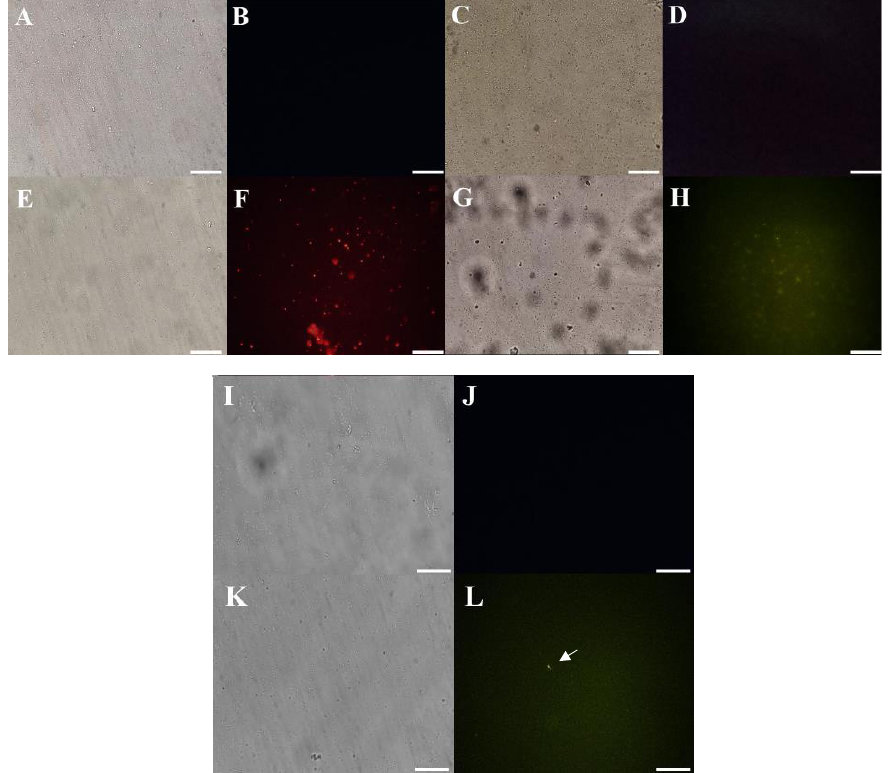
Figure 3. Mechanism of action of Mo -CBP 3 -PepI assessed by fluorescence microscopy. In all ex- periments, Mo -CBP 3 - PepI was used at a concentration of 31.26 µg mL −1 . ( A , B ) control K. pneumoniae cells for PI uptake assay. ( E , F ) Mo -CBP 3 -PepI-treated K. pneumoniae cells for PI uptake assay. Red fluorescence ( F ) indicates pore formation induced by Mo -CBP 3 -PepI. ( C , D ) control K. pneumoniae cells for FITC-Dextran uptake assay. ( G , H ) Mo -CBP 3 -PepI-treated K. pneumoniae cells for FITC-Dex- tran uptake assay. Green fluorescence ( H ) indicates 10-kDa -sized pore formation induced by Mo - CBP 3 -PepI. ( I , J ) control K. pneumoniae cells for ROS overproduction assay. ( K,L ) Mo -CBP 3 -PepI- treated K. pneumoniae cells for ROS overproduction assay. Green fluorescence ( L ) indicates pore for- mation induced by Mo -CBP 3 - PepI. Bars indicate 100 µm.